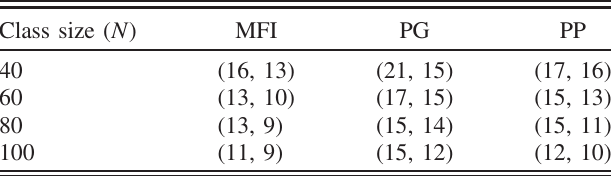
TABLE I. Dependence of minimal test length ( l class size.